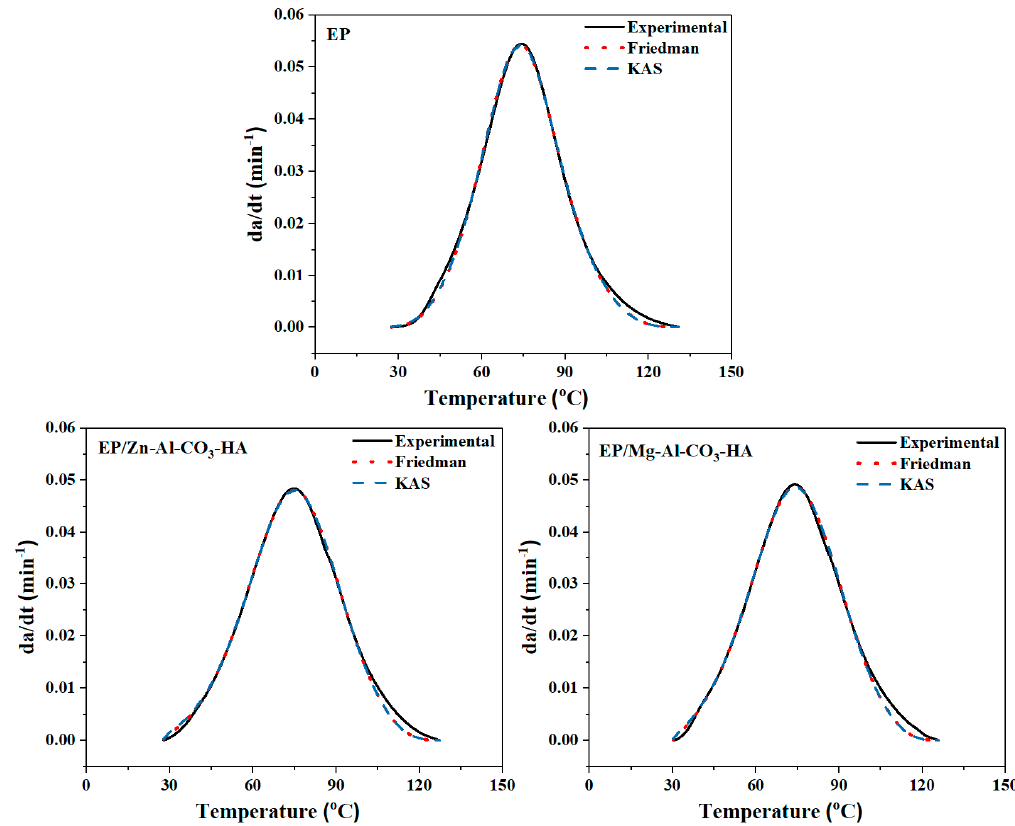
Figure 9. Comparison of the experimental curing rates with the values obtained from the kinetic models ( Friedman and KAS ).